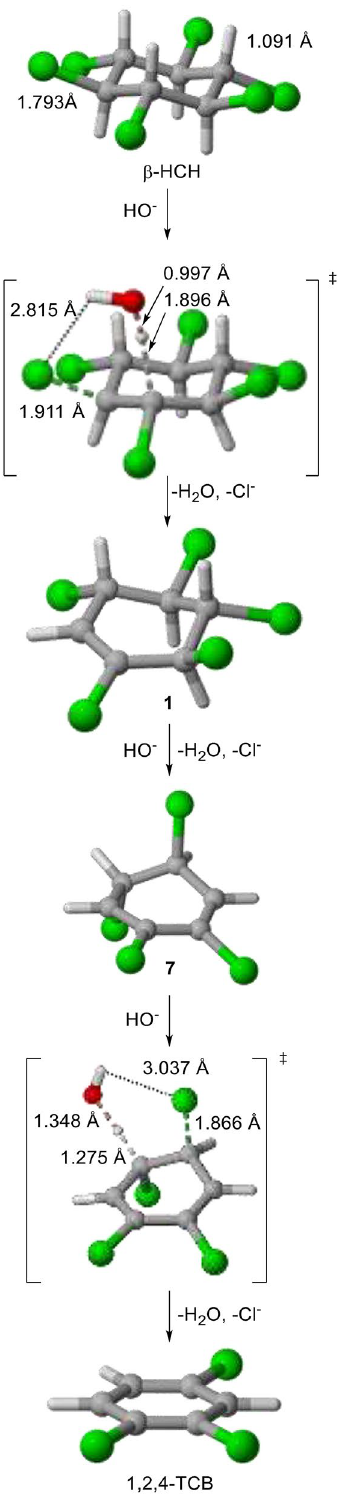
Figure 4. Preferred reaction path for the complete β-HCH + hydroxide anion elimination. Three-dimensional structures were generated using CYLView 44